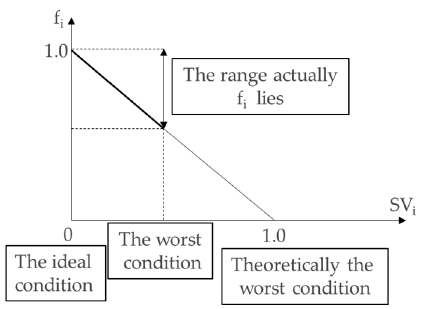
Figure 7. Framework for adjustment factor module